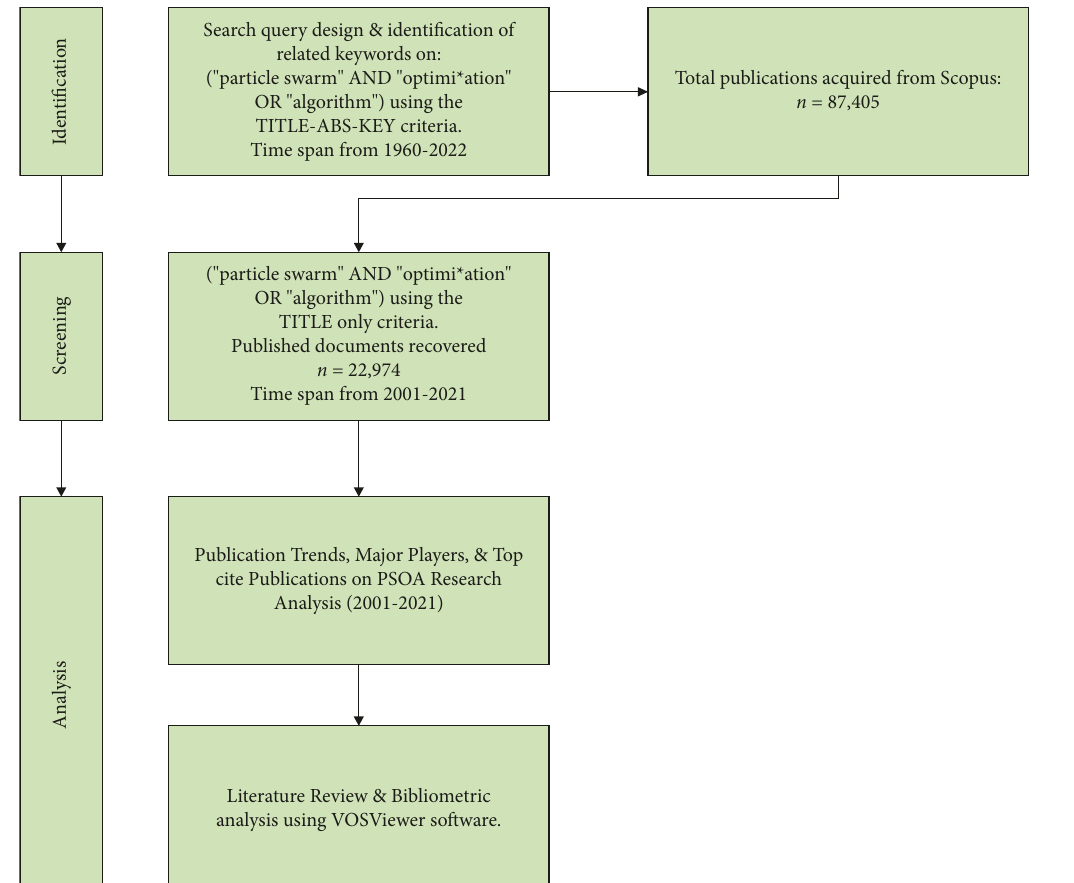
Figure 1: Process schematic for identification, screening, and analysis of published documents on PSOA research from scopus database.